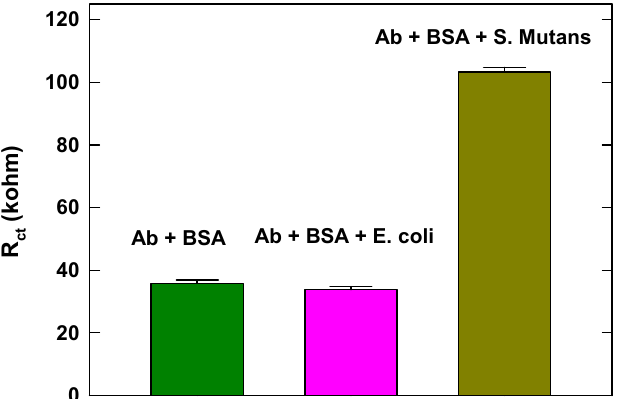
Figure 5. Specificity behavior of the developed biosensor in discriminating S. mutans against E. coli .